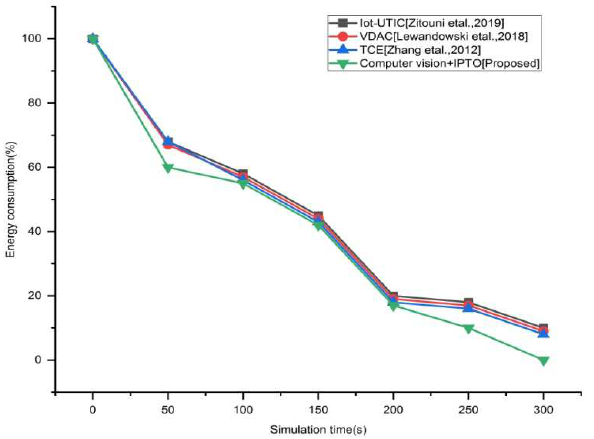
Figure 6. Average energy consumption vs. simulation time for the existing and proposed method.